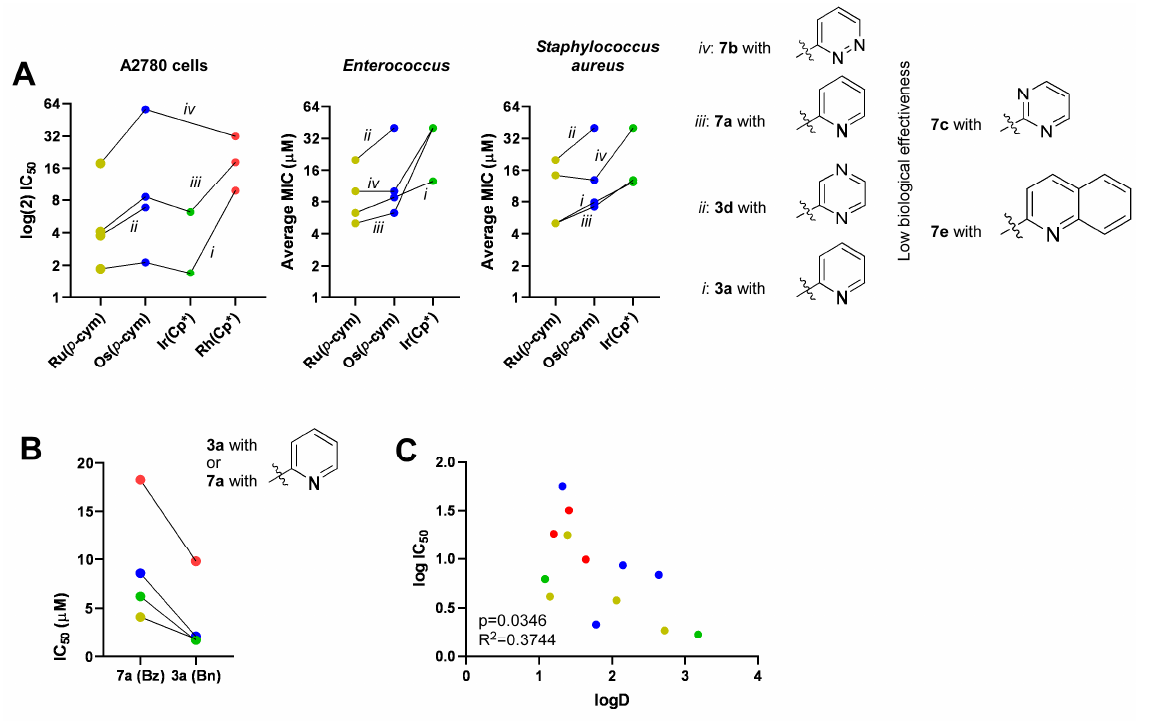
Figure 10. Correlations between the structural features and the bioactivity of the complexes with O -protected C -glucosaminyl azines in neoplastic cell models. ( A ) The effect of the heterocyclic aglycon and the arene/arenyl metal ion parts on the IC 50 and average MIC values. The MIC values of the reference strain and the multiresistant clinical isolates were averaged. ( B ) The effect of the O -protective groups (benzoyl (Bz) vs. benzyl (Bn) groups) on the IC 50 values of the 7a and 3a complexes. ( C ) Correlation between the apolar character (logD values) and the bioactivity (IC 50 values) of the complexes. The logD values and the corresponding logIC 50 values were plotted, and the Pearson correlation was calculated. Color code: khaki—ruthenium complex, blue—osmium complex, green—iridium complex, red—rhodium complex.